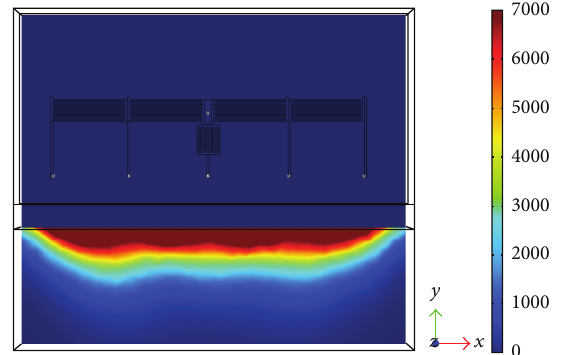
Figure 6: Top view of the applicator with symmetrical feeding, water bolus, and the tissue. SAR distribution in the area to be treated is also displayed here.